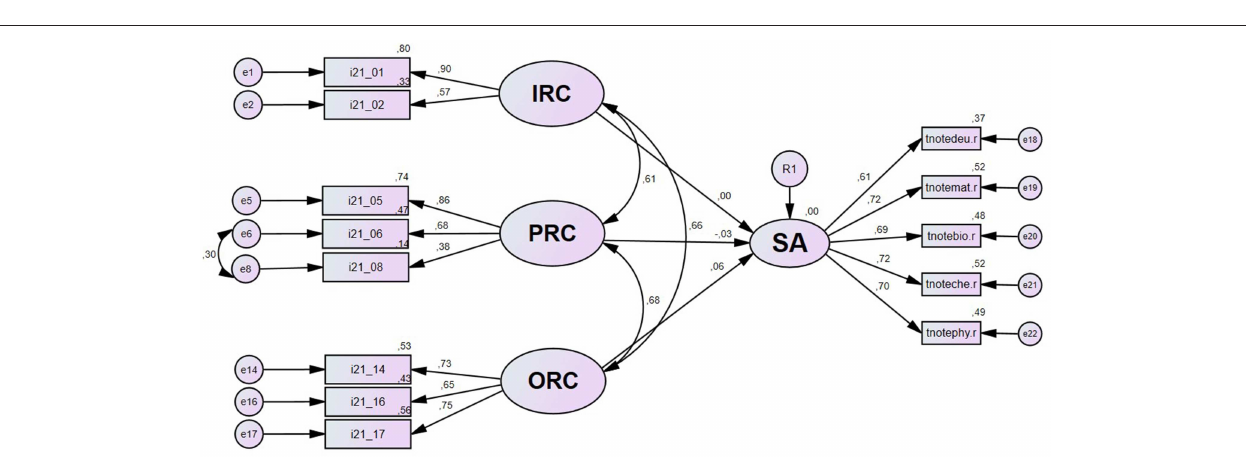
FIGURE 3 | Structural model of three forms of collaboration and student achievement